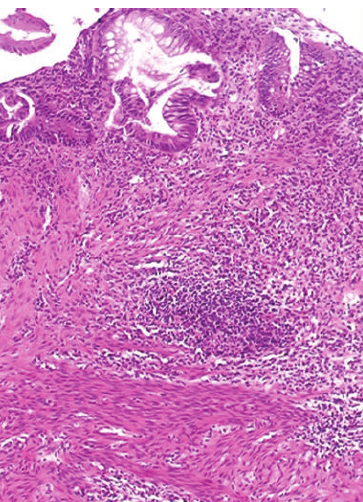
Figure 3: Colonic biopsy showed focally branched and distorted glands and heavy infiltration by lymphocytes, plasma cells, and eosinophils. The muscularis mucosa is thickened and